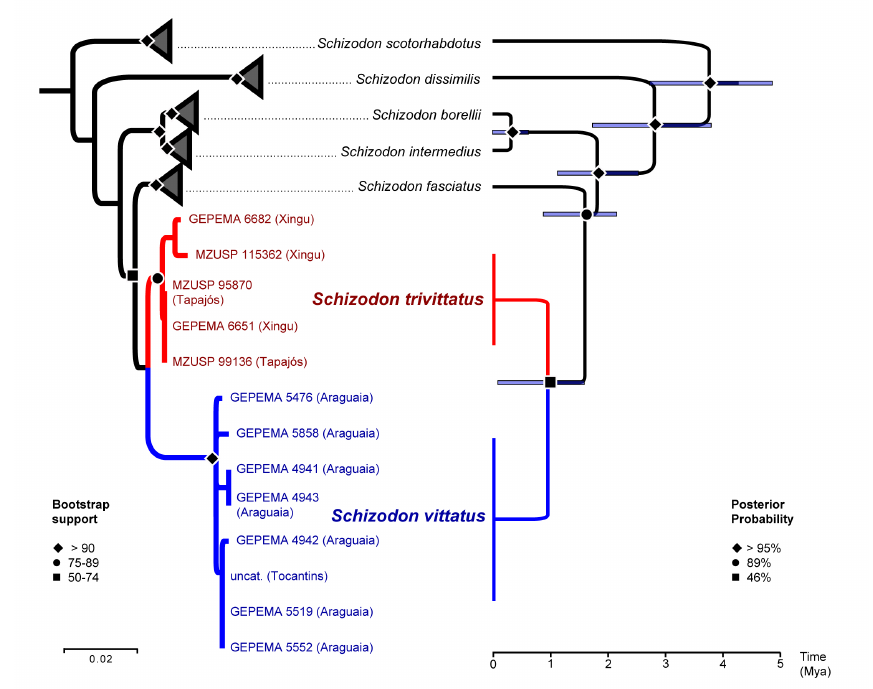
FIGURE 2 | Phylogenetic relationships among species of the Amazonas clade of Schizodon based on: (left) Maximum Likelihood analysis using COI sequences, (right) dated Bayesian analysis using COI, RAG1, RAG2, Cytb, and Myh6 sequences. Node bars on the right consist of 95% confidence age height.